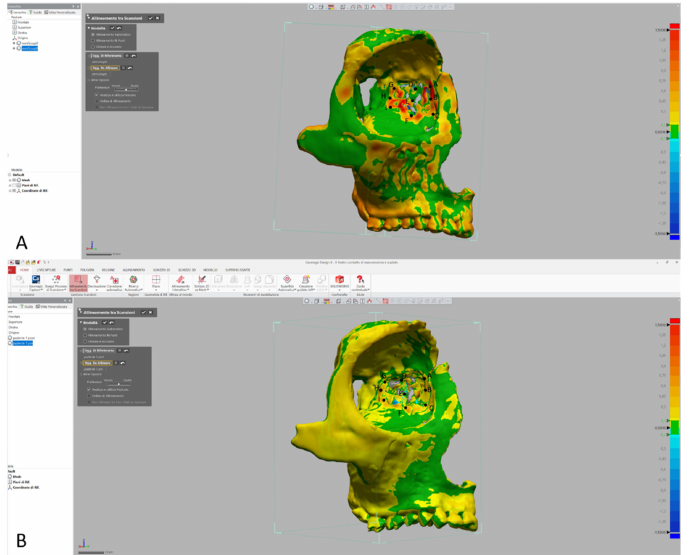
Figure 4. Color map distance between specular healthy orbit and affected orbit post treatment in the immediate postoperative time in Geomagic Design X software with the nine anatomical points considered. ( A ) Group A patient. ( B ) Group B patient. Appl. Sci. 2023 , 13 , 98